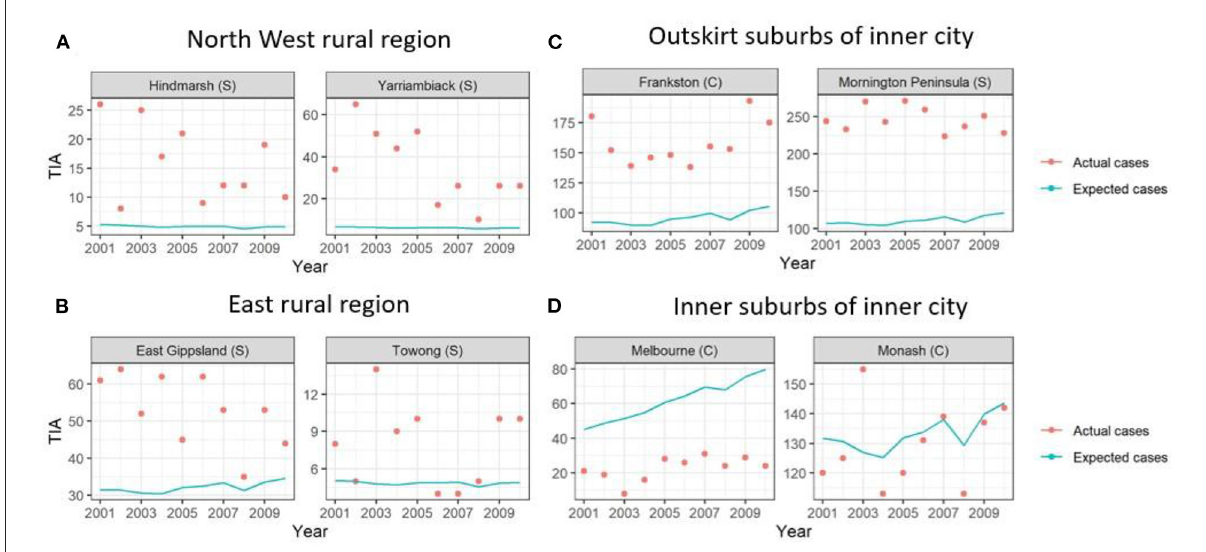
FIGURE2 Graphs of example LGAs highlighting actual cases compared to expected cases over 2001-2010. Actual cases (red dots) were higher than the expected cases (blue line) in (A) North West rural region and (B) East rural region and (C) outskirt suburbs of inner city, highlighting TIA hot spots. This is in comparison to the (D) inner suburbs of the inner city, where the actual cases were similar to expected cases or lower.